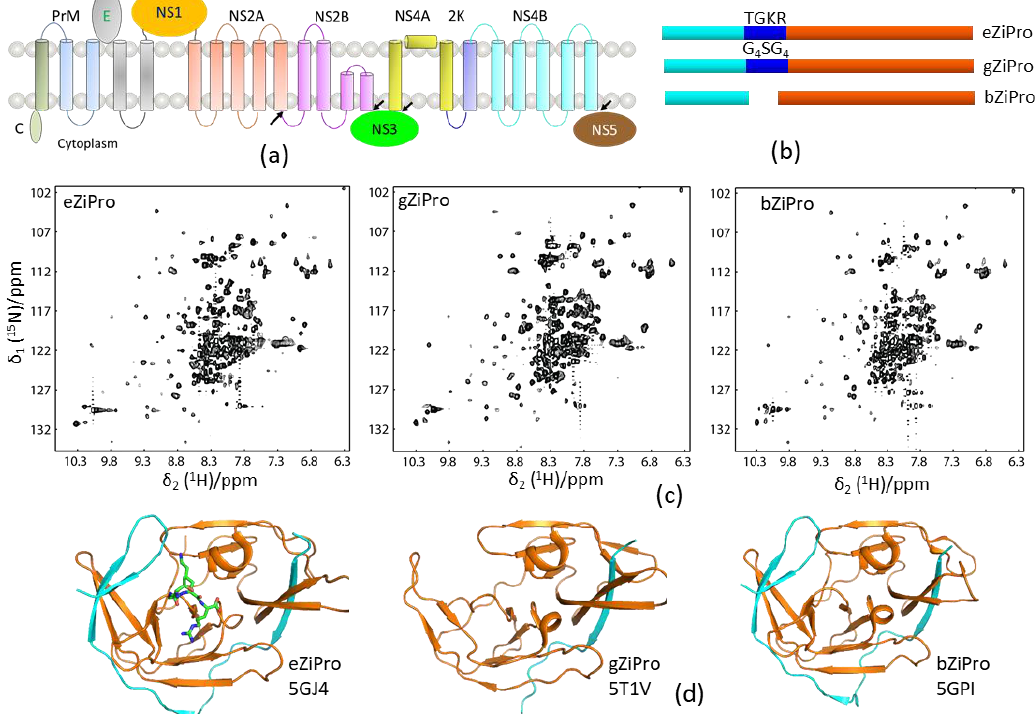
Figure 4. Solution NMR spectra of di ff erent protease constructs. ( a ) Diagram of the viral polypeptide. The arrows indicate the viral protease cleavage